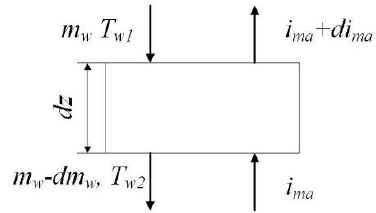
Figure 1. Heat and mass transfer in a finite volume of the cooling tower.